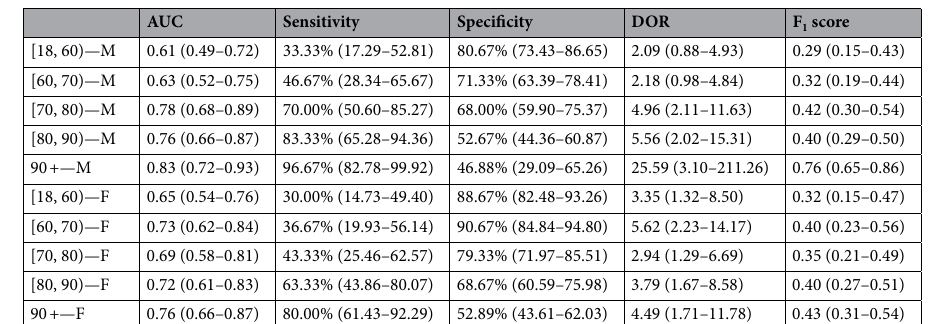
Table 4. Comparison of the performances obtained for age-sex-specific groups of patients with the ResNet model. We evaluate the same ResNet model with ten age-sex-specific test sets. The model is trained with ECG samples that fairly represent all the ten groups of patients. To compute the metrics additional to AUC, we set a unique threshold for the ResNet model, as described in “Methods”. Performances are assessed according to the aggregation rule by average. 95% confidence intervals are reported in brackets. M Male, F Female, AUC Area Under the Curve, DOC Diagnostic Odd